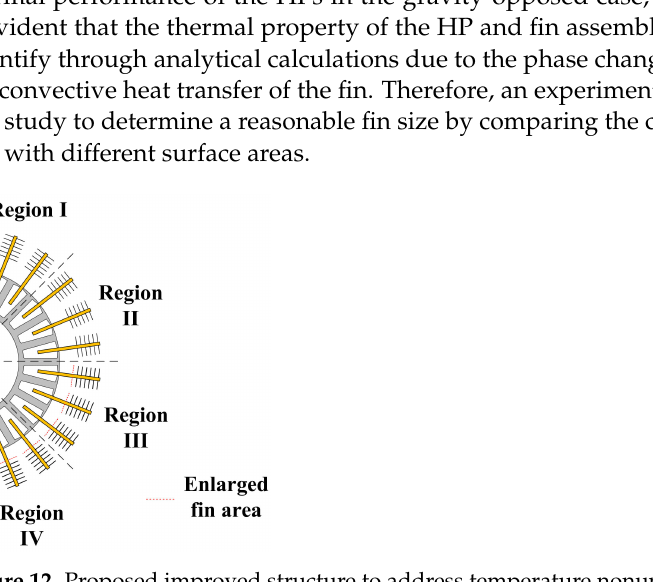
Figure 12. Proposed improved structure to address temperature